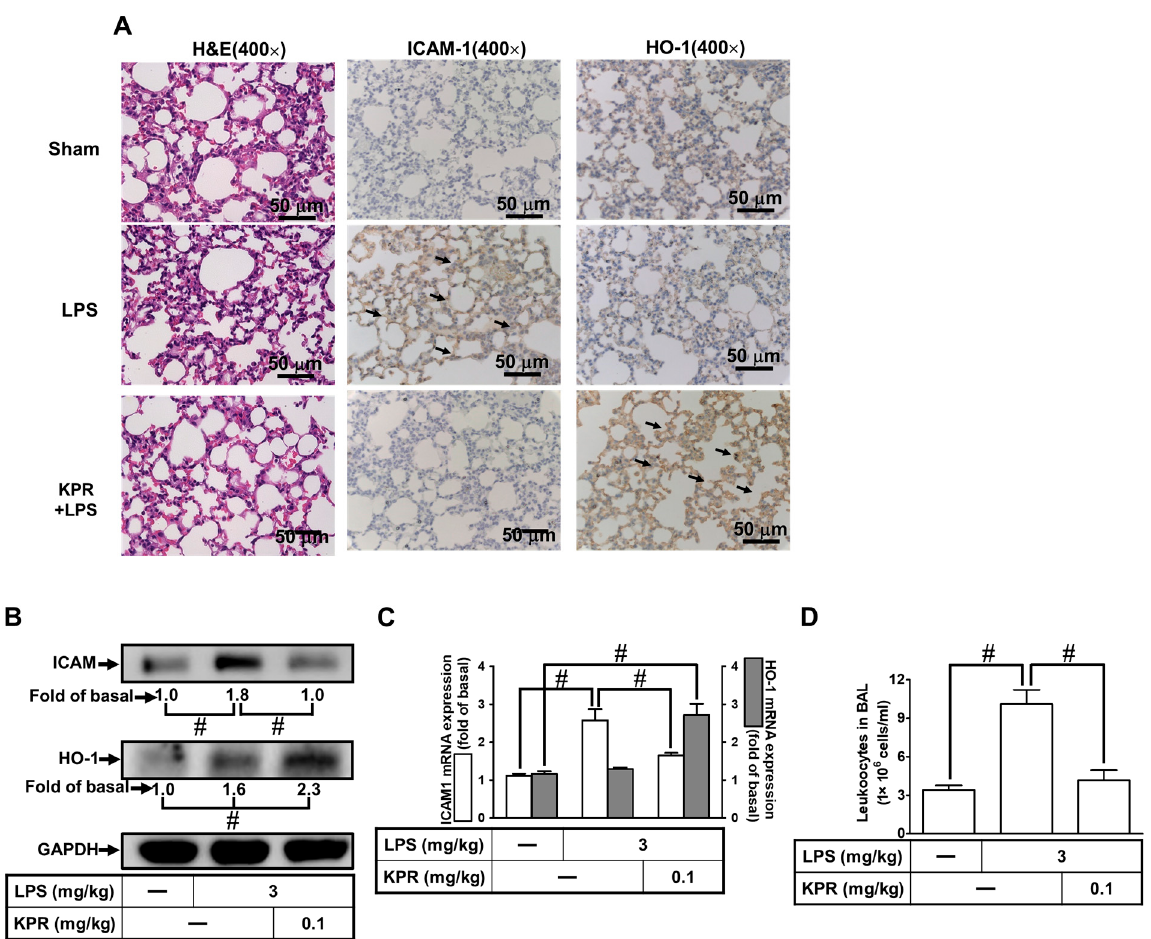
Figure 2. Upregulation of HO-1 by KPR attenuates LPS-induced pulmonary inflammatory responses in vivo. ( A ) Mice were intra-peritoneally pretreated with KPR (0.1 mg kg − 1 ) or vehicle for 1 h, and then intratracheally administered with or without LPS (3 mg kg − 1 ) for 16 h. H&E and immunohistochemical staining for ICAM-1 and HO-1 in serial sections of the lung tissues from Sham (0.1 mL of DMSO-PBS (1:100) with 0.1% ( w / v ) BSA treated mice), LPS (LPS-treated mice), and KPR + LPS (kaempferol plus LPS mice). The arrows indicate the ICAM-1 and HO-1 expression on pulmonary alveolar cells. All images are representative of five mice per group. ( B , C ) Lung tissues were homogenized to extract protein and mRNA. The levels of ICAM-1 and HO-1 protein ( B ) and mRNA ( C ) were determined by Western blot and real-time PCR. ( D ) Leukocyte count in the bronchoalveolar lavage fluid (BALF) of sham, LPS, and KPR + LPS groups. Data are expressed as mean ± SEM ( n = 5), analyzed with one way ANOVA and Dunnett’s post hoc test. # p < 0.01, as compared with the cells exposed to vehicle alone; or significantly different as indicated.